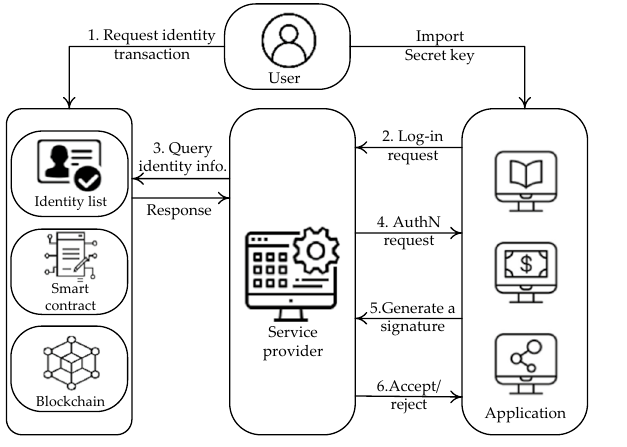
Figure 3. Decentralized